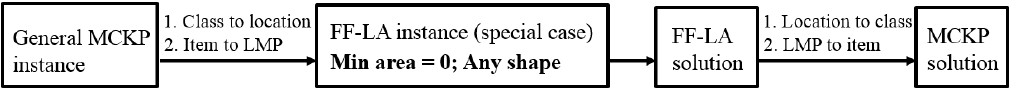
Figure 2. Reduction from the multiple-choice knapsack problem (MCKP) to the fragmentation-free land allocation (FF-LA). LMP: land management